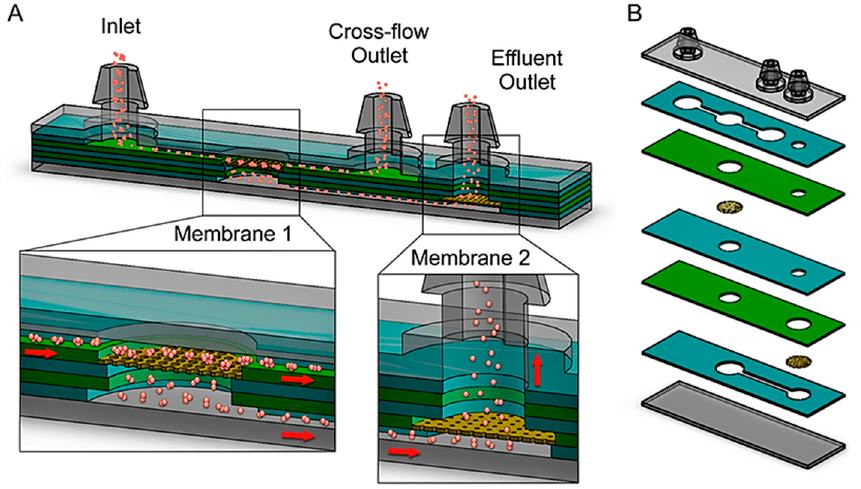
Figure 15. Microfluidic filter device for tissue specimens. (a) Schematic of the microfluidic filter device containing two microporous membranes. The first membrane is located in the centre of the device and is intended to restrict large tissue fragments and aggregates from passing through to the effluent outlet (direct filtration). If desired, some of the sample can be passed over the surface of the first membrane for collection from the crossflow outlet (tangential filtration). The second membrane is immediately upstream of the effluent outlet and is intended to restrict smaller aggregates from reaching the effluent outlet. (b) Exploded view showing seven PET layers, including three channel layers, two via layers, and two layers to seal the top and bottom of the device. (Re-printed from Qiu et al. [121]. Copyright (2018), with permission from The Royal Society of Chemistry).